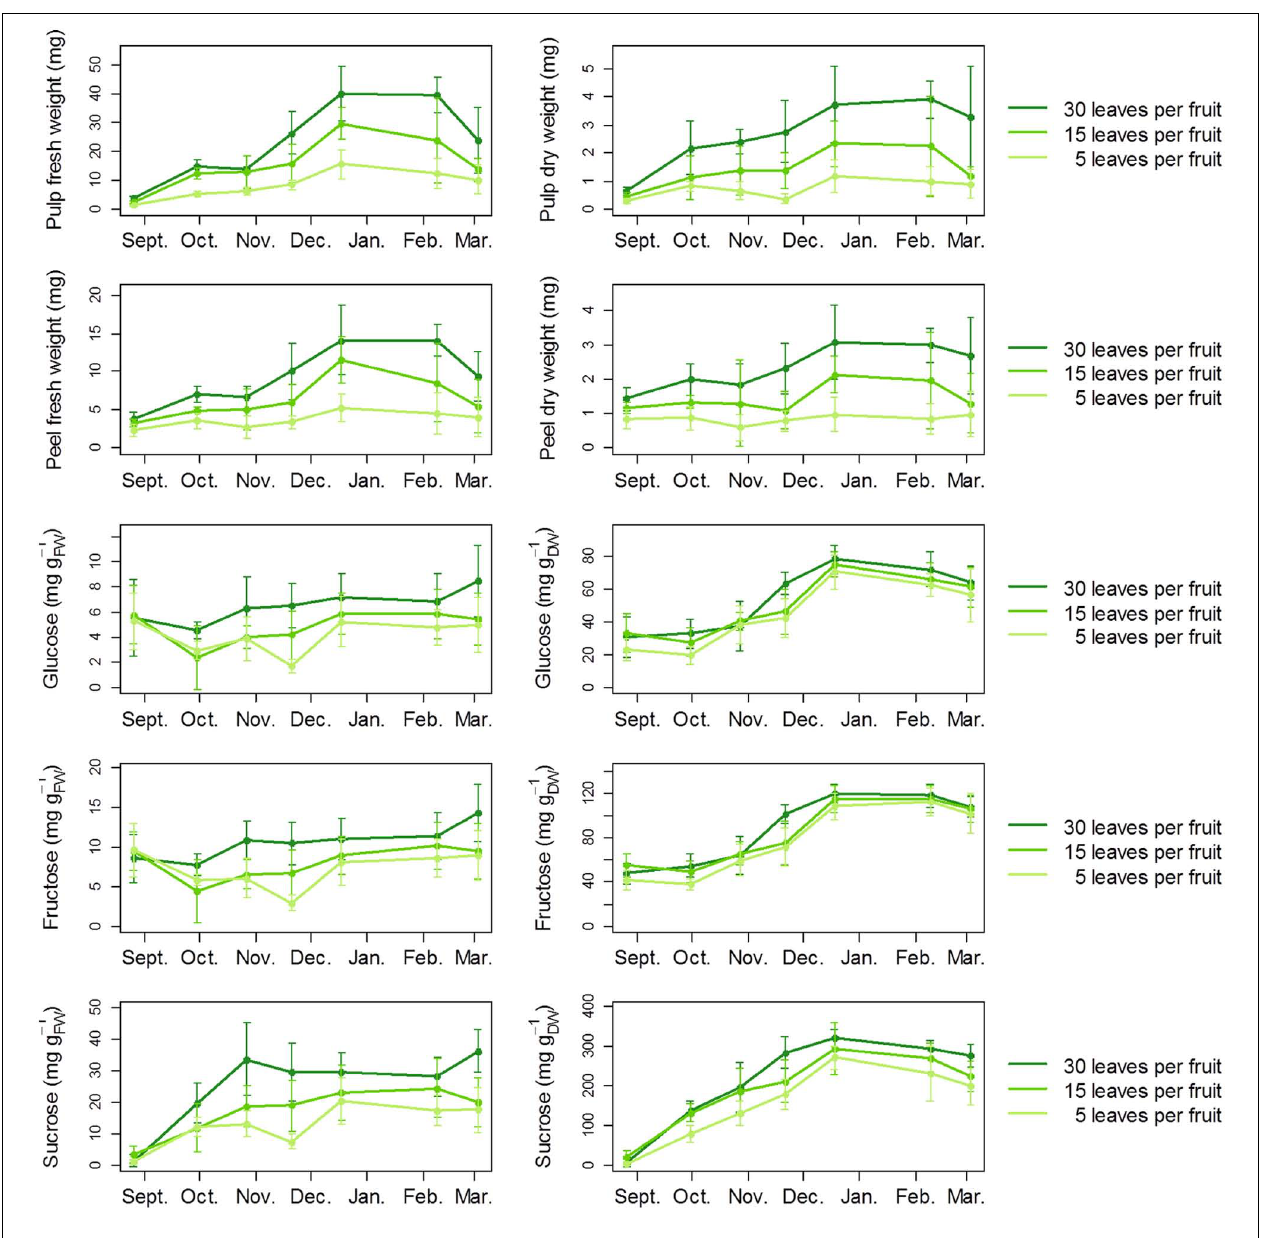
FIGURE 6 | Developmental changes in clementine fruit growth and soluble sugar contents according to carbon availability. To probe the effect of carbon availability on fruit growth in field conditions, a defoliation treatment was applied on girdled fruiting branches from adult clementine trees to obtain three levels of leaf-to-fruit ratio: 5, 15, and 30 leaves per fruit. The leaf-to-fruit ratio 30 corresponds to